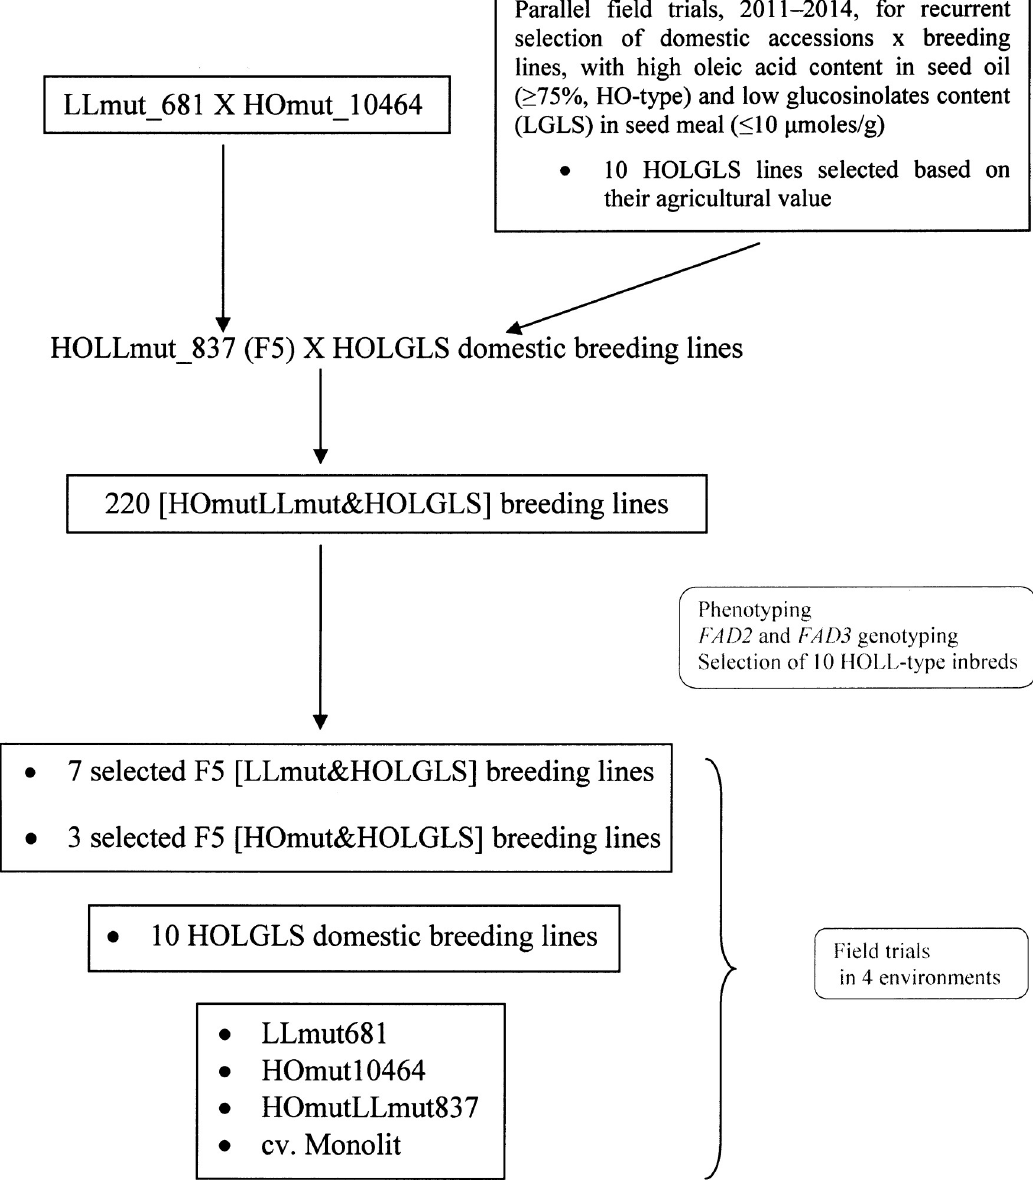
Fig 1. Breeding scheme used in this study. HOmut and LLmut, high oleic and low linolenic WOSR mutant lines obtained by chemical mutagenesis (EMS); HOLLmut, recombinant line obtained by crossing HOmut and LLmut lines; FAD2 and FAD3 genotyping with the use of specific DNA markers for monitoring mutated alleles of FAD2 and FAD3 fatty acid desaturase genes, responsible for biosynthesis of oleic and linolenic acids in seed oil,